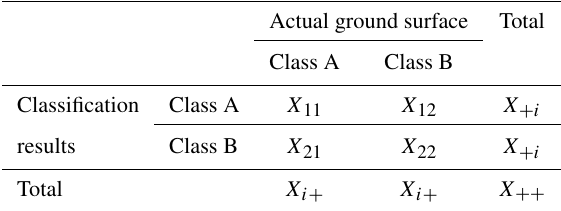
Table 1. Relationship table of error matrix (Verbyla, 1995). Actual ground